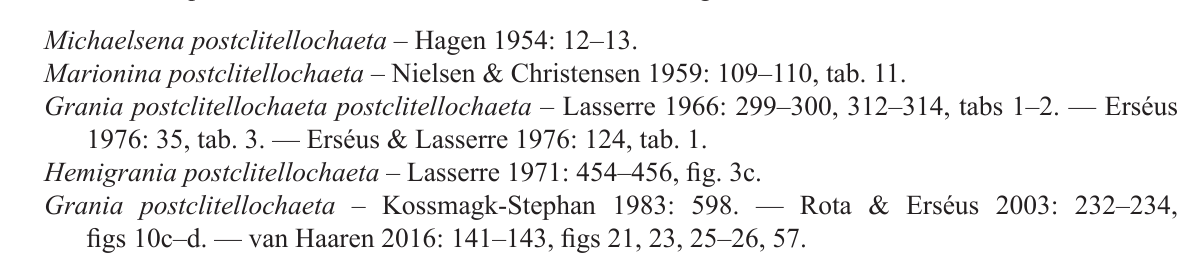
figs 10c–d. — van Haaren 2016: 141–143, figs 21, 23, 25–26,